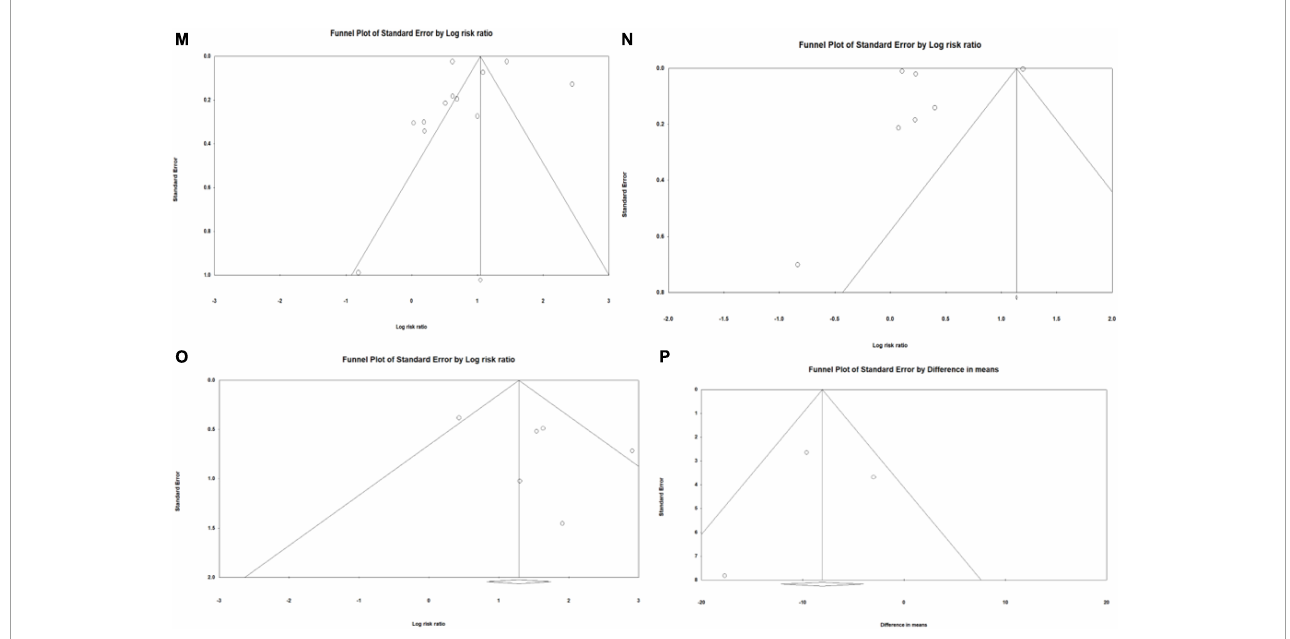
FIGURE3 Funnel plots of publication bias investigating association between frailty and health outcomes for patients who underwent vascular surgery. (A) In-hospital mortality. (B) Post-discharge mortality. (C) Length of hospital stay. (D) Rehospitalisation. (E) Discharge location. (F) Post-operative myocardial infarction. (G) Renal failure. (H) Stroke. (I) Hypertension. (J) Cardiovascular disease (CVD). (K) Peripheral vascular disease (PVD). (L) Diabetes. (M) Chronic obstructive pulmonary disease (COPD). (N) Chronic kidney disease (CKD). (O) Cognitive impairment. (P) Estimated glomerular filtration rate